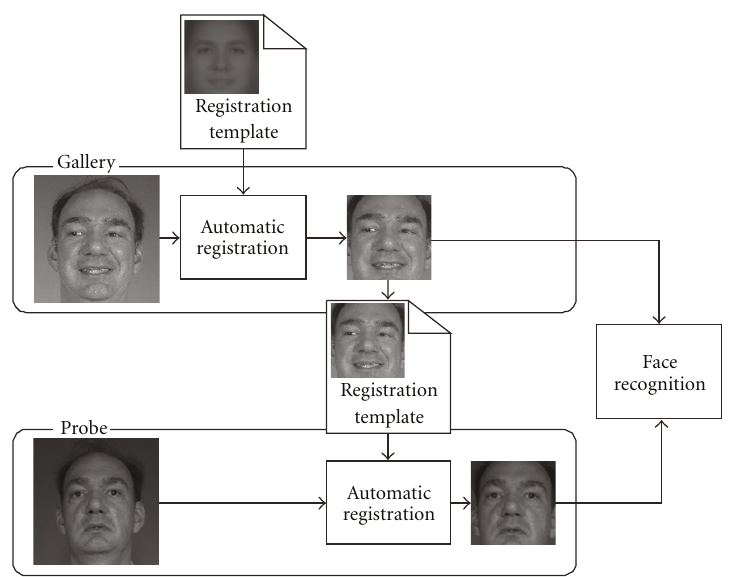
Figure 5: Schematic representation of user-specific registration, where the template is an automatically registered gallery image.